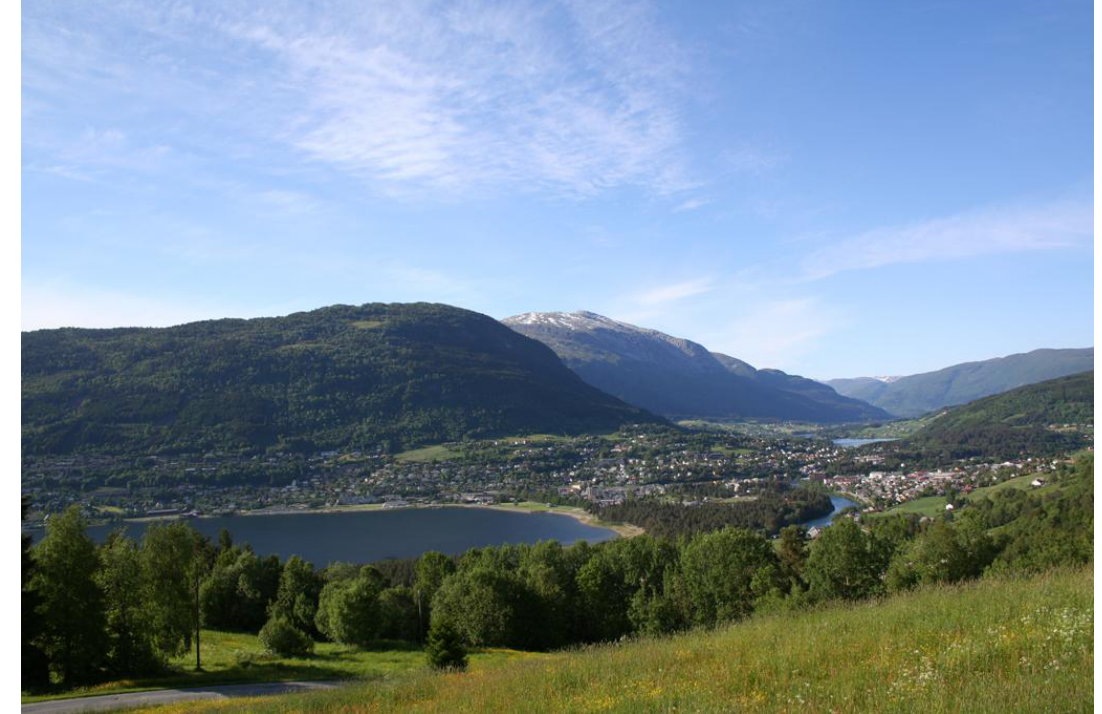
Figure 2. The town of Voss and its natural surroundings (Photo: Terje N. Wikimedia Commons